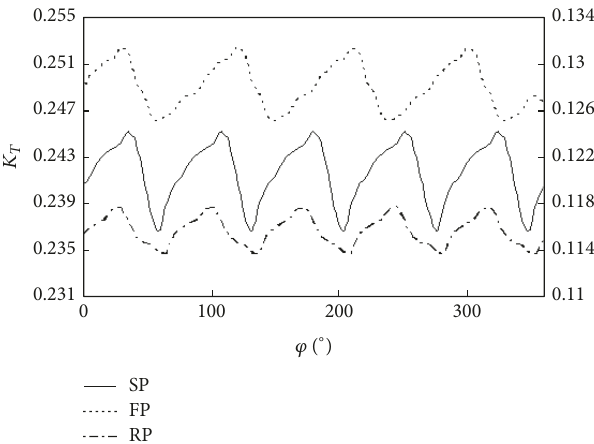
Figure 10: Thrusts over one revolution for single propeller (SP) and CRP (FP: front propeller, RP: rear propeller).